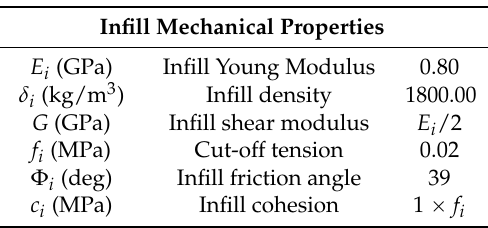
Table 4. Mechanical properties adopted for the infill simulation.